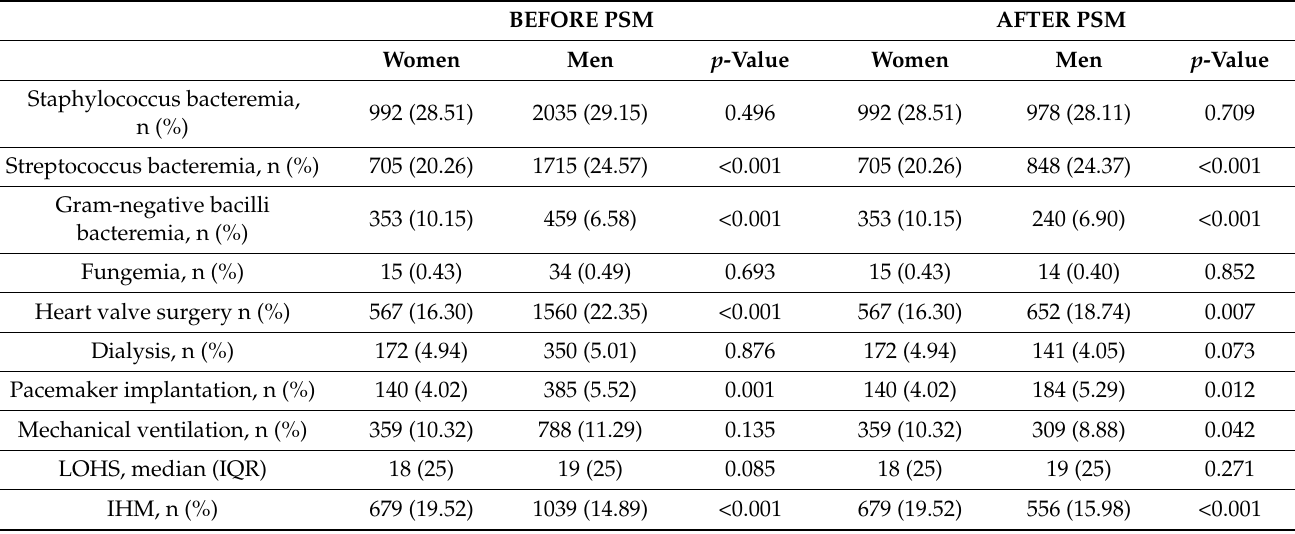
Table 3. Distribution of isolated pathogens, therapeutic procedures, and hospital outcomes among women and men with infective endocarditis in Spain (2016 – 20), before and after propensity score matching (PSM).